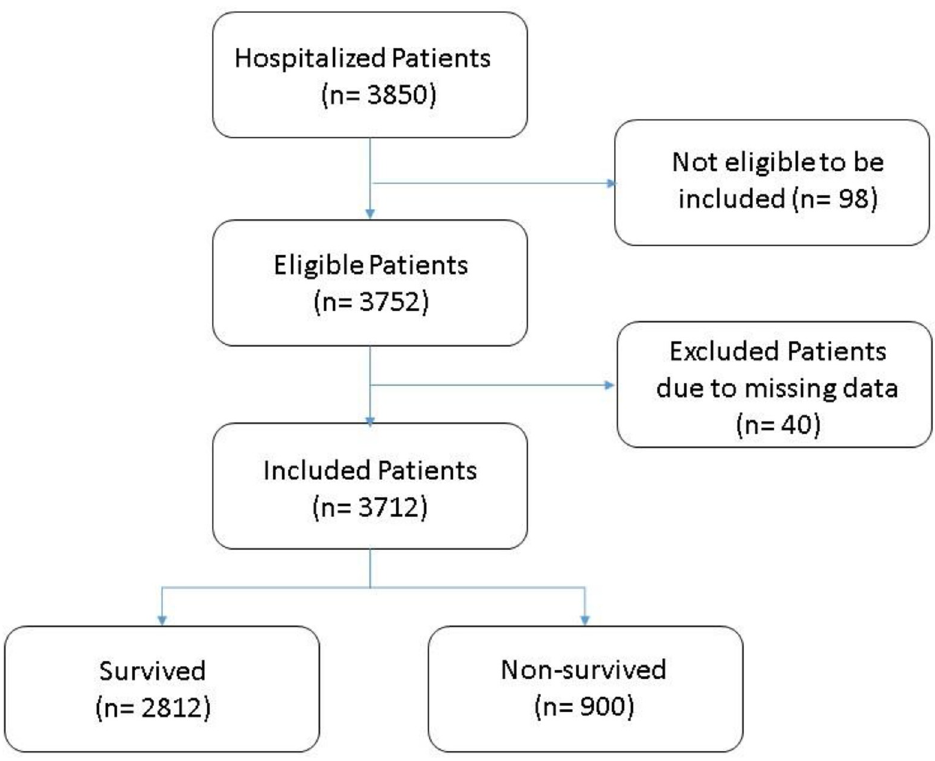
Fig 1. Flow chart of Egyptian COVID-19 patients included in the